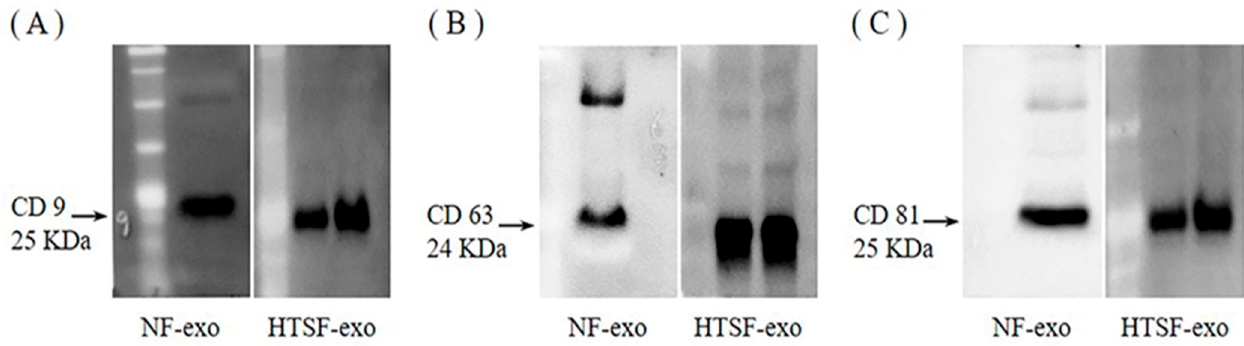
Figure 1. Expression of exosome surface markers. Western blot analyses of CD 9 ( A ), CD 63 ( B ), and CD 81 ( C ) expression in normal fibroblast (NF)- and hypertrophic scar fibroblast (HTSF)-exosomes. Exosomes were isolated from the serum-free culture media of fibroblasts derived from post-burn HTS. Western blot analyses were performed in triplicate.